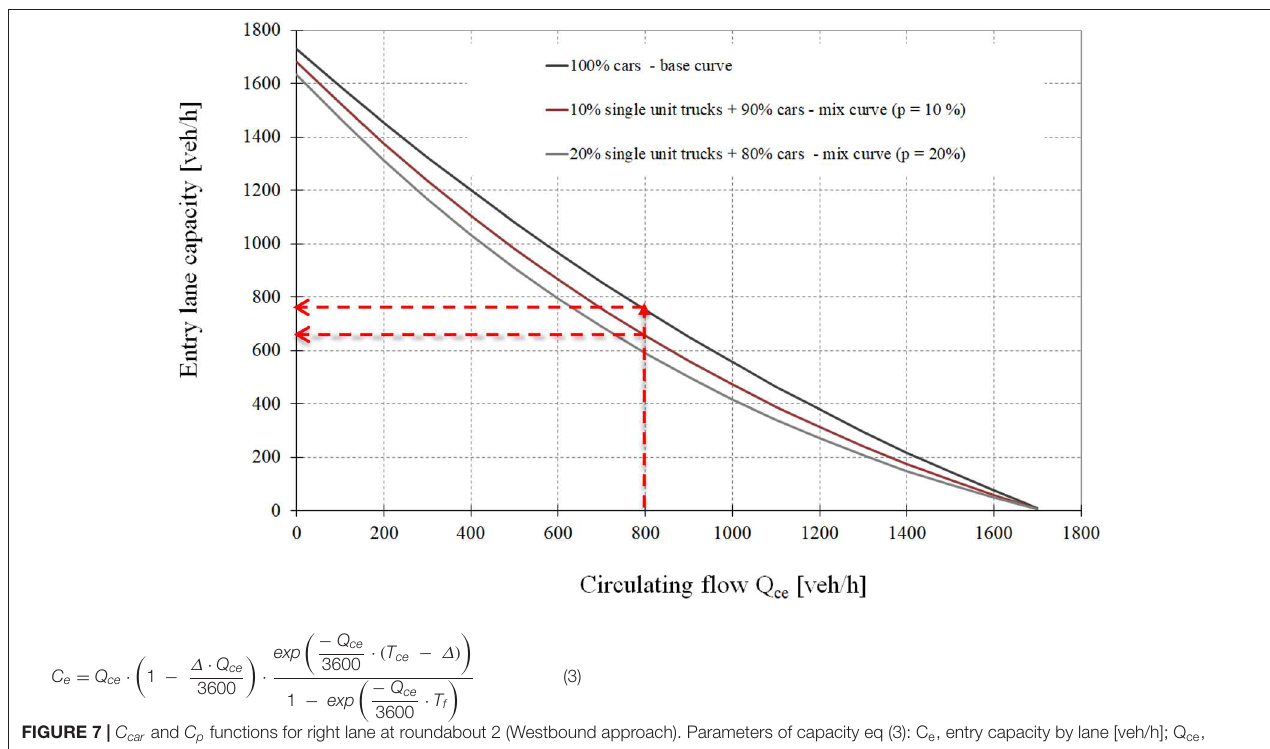
FIGURE 7 | C car and C p functions for right lane at roundabout 2 (Westbound approach). Parameters of capacity eq (3): C e , entry capacity by lane [veh/h]; Q ce , circulating flow on the outside lane [veh/h]; 1 = 2.10s; T ce , critical headway (outside lane) [s]; T f , follow up headway [s]; C car , capacity function under 100% cars; C p , capacity function under p -percentage of heavy vehicles.